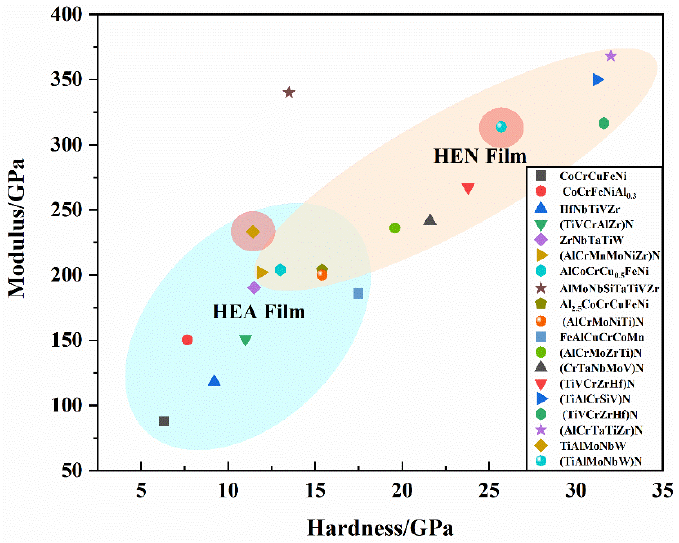
Figure 10. Comparison of mechanical properties of other materials with high-entropy alloy films in this study [6,7,10,34–45].